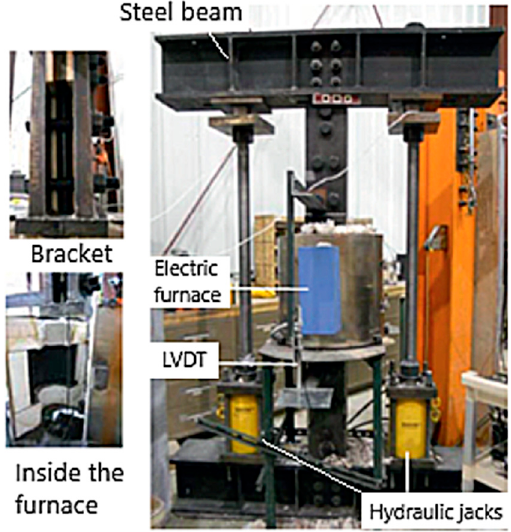
Figure 5. Test setup for FRP composite strength test at elevated temperatures.